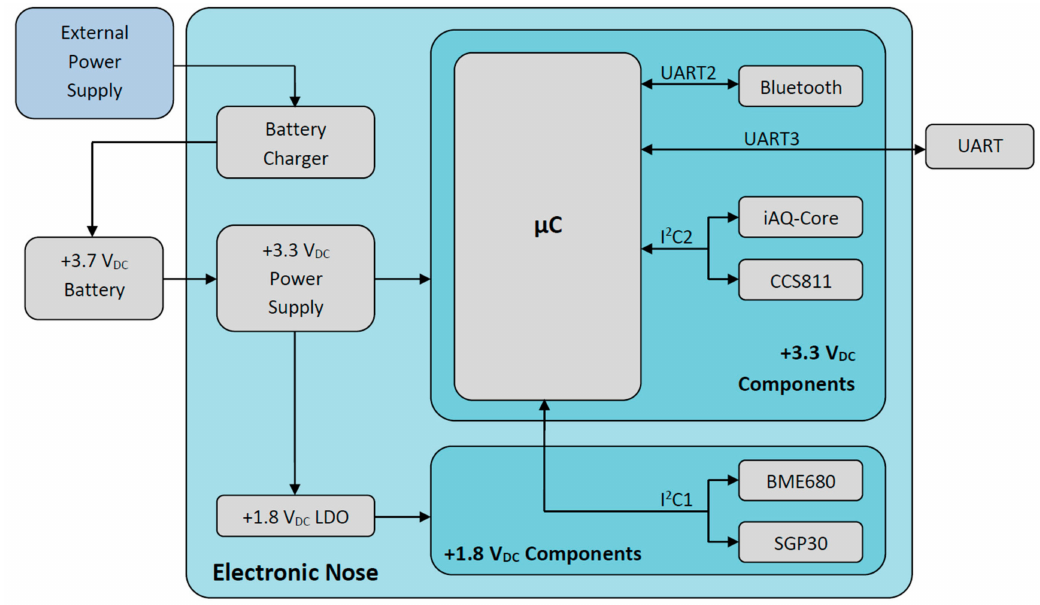
Figure 1. Block diagram of the developed electronic